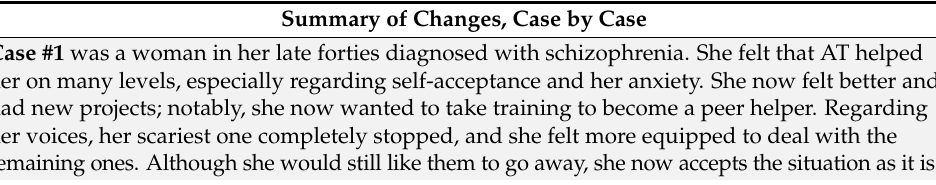
Table 2. Description changes following therapy for each participant. Summary of Changes, Case by